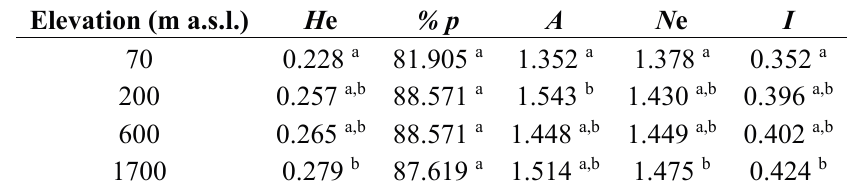
Table 2. Parameters of genetic variation in Platanus mexicana on the Colipa River, Veracruz, Mexico. Elevation (m a.s.l.)